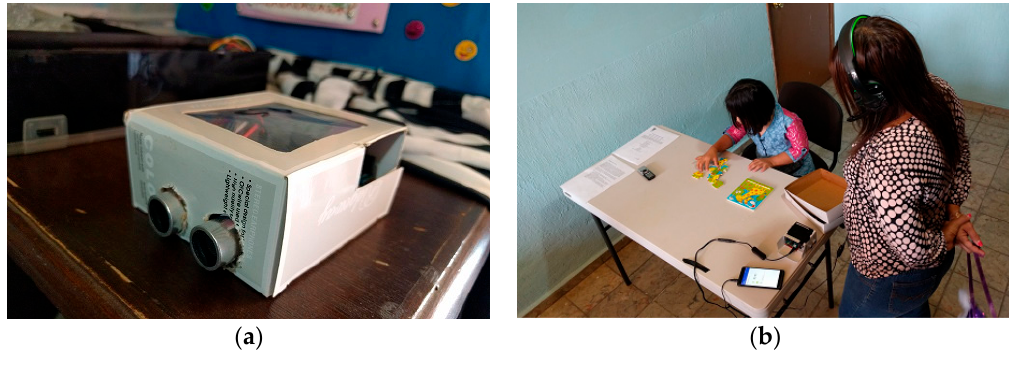
Figure 6. Collective sensing use